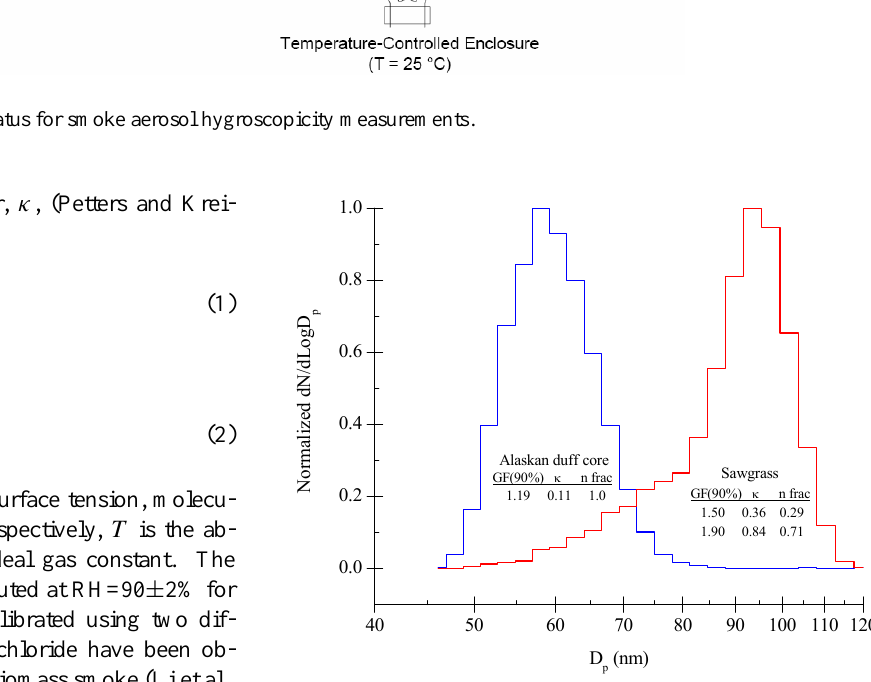
Fig. 2. Example size distributions after humidification, for dry D p = 50 nm. A unimodal, relatively low hygroscopicity case (Alaskan duff core) is shown in comparison to a strongly hygroscopic and bimodal case (sawgrass). Values tabulated inside each distribution are the derived GF at 90% RH, the associated κ value, and the number fraction of particles assigned to each hygroscopicity mode.